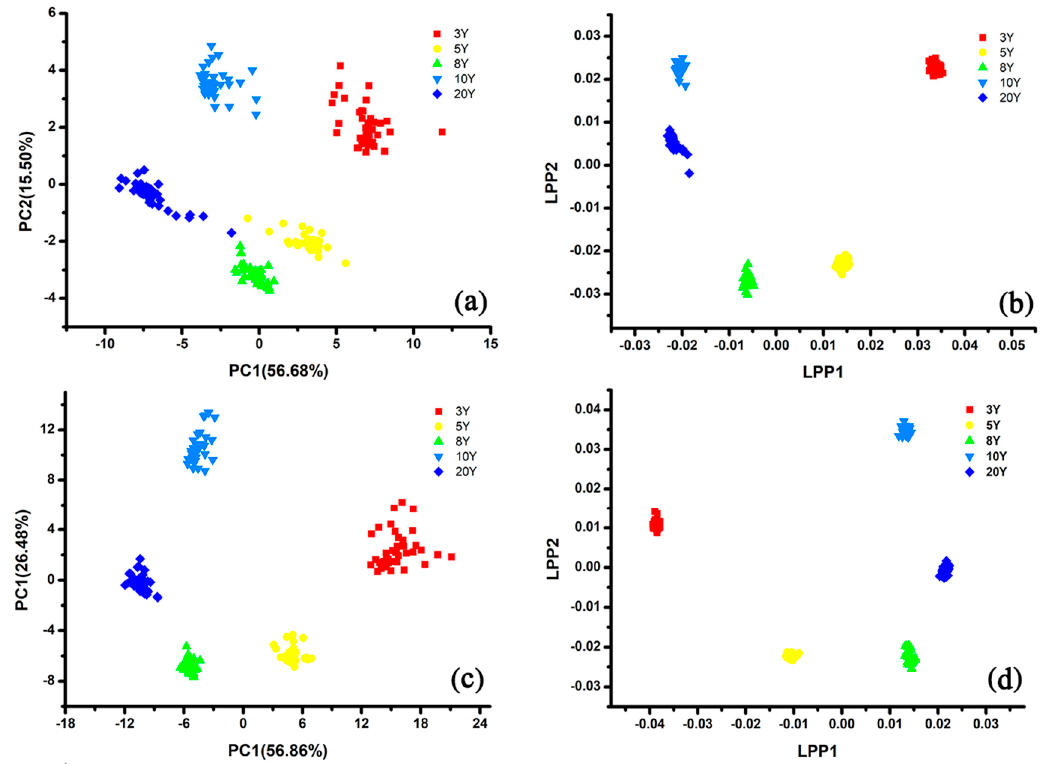
Figure 7. PCA and LPP score plots of the area features data sets obtained from four fusion methods: ( a , b ) Direct-fusion data set, ( c , d ) weighted-fusion data set.